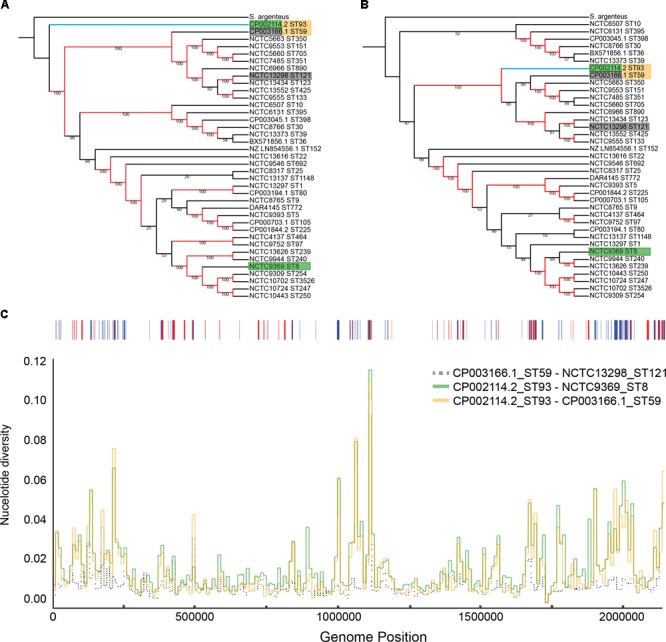
Phylogenetic position of ST93 in relation to other Staphylococcus aureus. Maximum-likelihood cladograms (RAxML, GTR+G) generated from complete reference genomes from a core alignment with progressiveMauve before (A) and after (B) removing recombination with Gubbins. Red branches indicate branches with bootstrap support of 100 and indicate strong support for an early divergence of ST93 (indicated by the blue branch) outside the main group of S. aureus sequence types (A). Following masking of recombination, ST93 is located within the larger S. aureus complex basal to a larger clade containing other regional clones like ST59 and ST121 (B). Colored boxes around tip labels indicate isolate pairs used in subsequent comparisons. (C) Pair-wise nucleotide divergence across a 10,000 bp sliding window along the S. aureus core genome with comparisons between ST59-ST121, ST93-ST59, and ST93-ST8. Bases affected by recombination as detected by Gubbins across the ST93 genome are represented above with shared ancestral events (red) and events unique to the ST93 terminal branch (blue). Terminal branch recombination regions align with genomic positions where ST93 is highly diverged compared to other S. aureus.